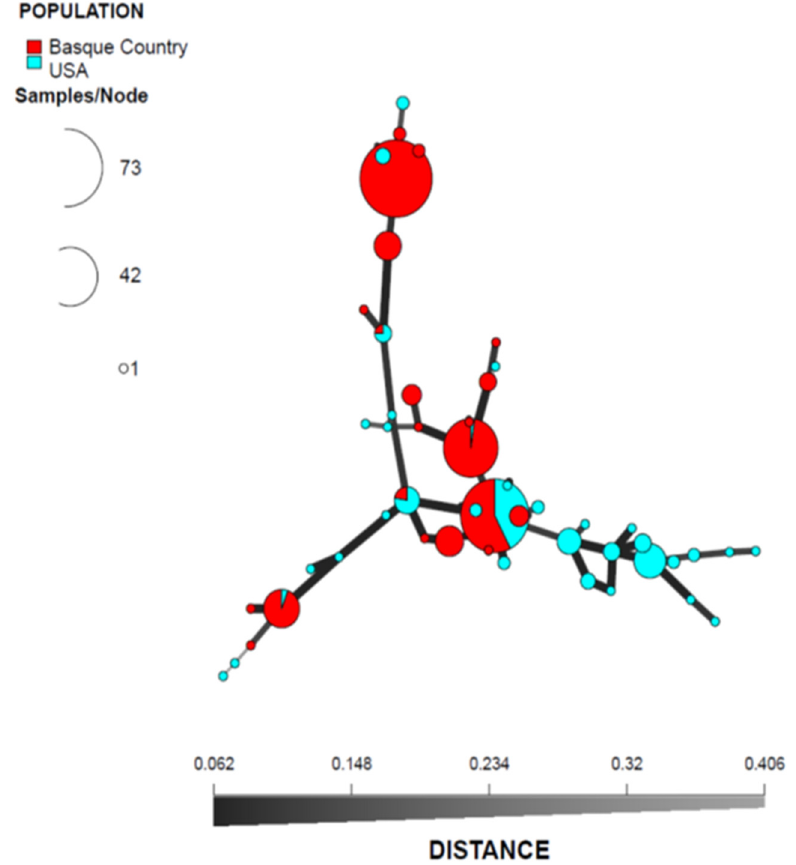
Figure 1. Minimum spanning network from the clone-corrected data showing the relationships among the individual multilocus genotypes (MLGs) found among the populations defined by country of origin (the Basque Country in Spain and USA). Each node represents a different MLG. The distances and thicknesses of the lines between nodes are proportional to Bruvo’s distance [63]. Node colors and sizes correspond to the population studied and the number of individuals, respectively.